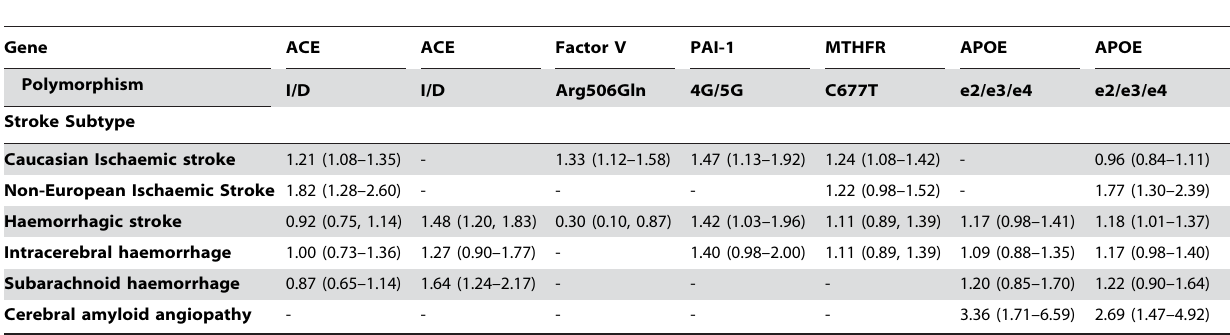
Table 3. Odds ratios and 95% CIs of gene variants investigated in both ischaemic and haemorrhagic stroke. Data taken from Casas et al. 104 and Ariyaratnam et al.